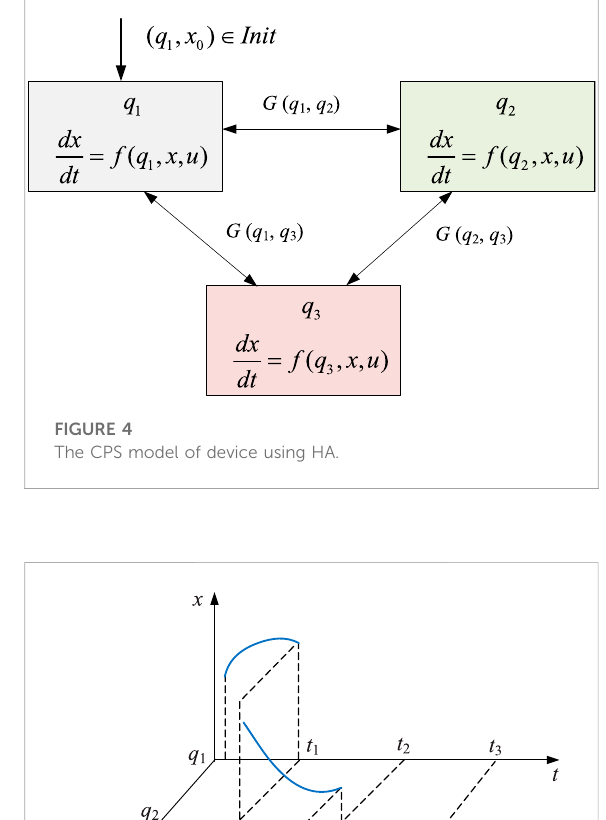
FIGURE 5 The evolution trajectory of the